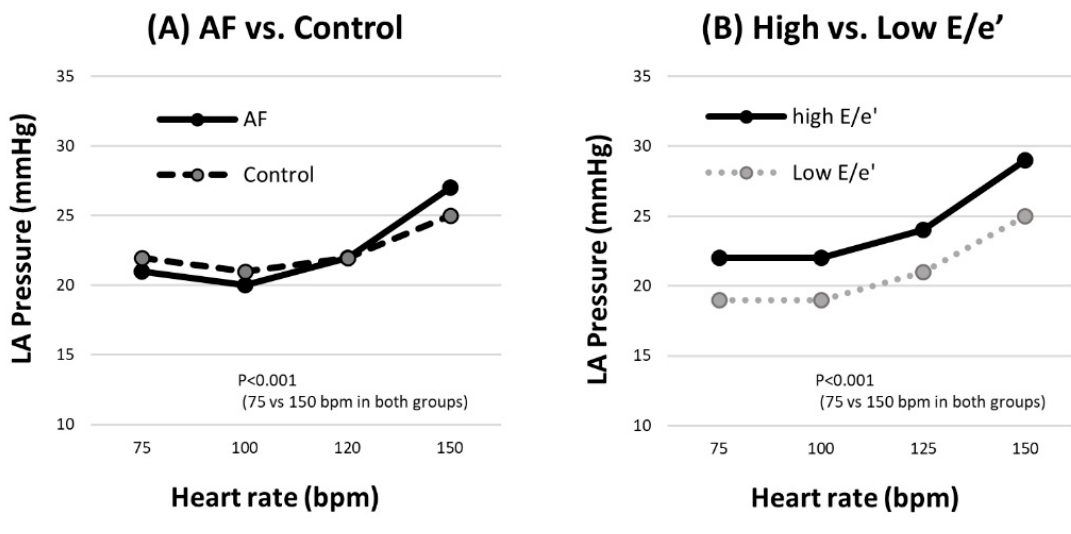
Figure 2. The pattern of heart rate dependent LA pressure response. ( A ) In AF and control groups, LA pressure response as heart rate change showed a similar pattern. ( B ) The different LA pressure response between both low and high E/e’ group. AF, atrial fibrillation; LA, left